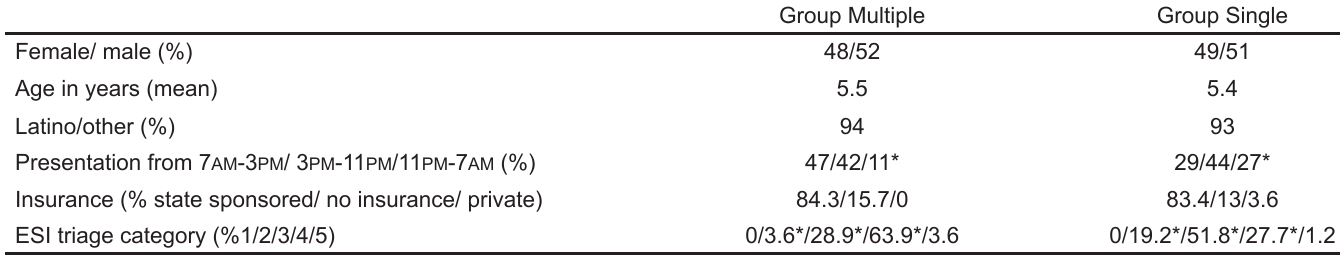
Table 1 . Demographic information of sibling pediatric patients presenting to the emergency